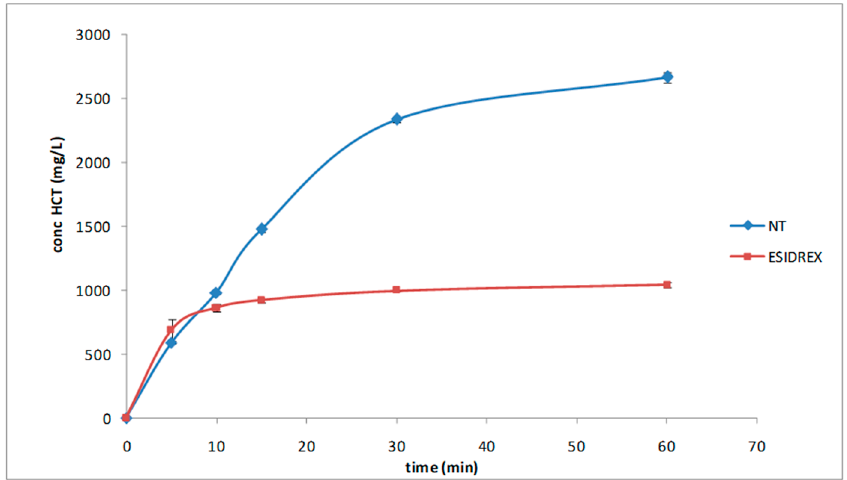
Figure 7. Dissolution profiles of HCT from the new tablet formulation and from the marketed tablet. The results proved the maintenance of the synergistic effect of NC and CD in improving the dissolution behavior also in the tablet formulation. Each value represents the mean of 3 measurements.